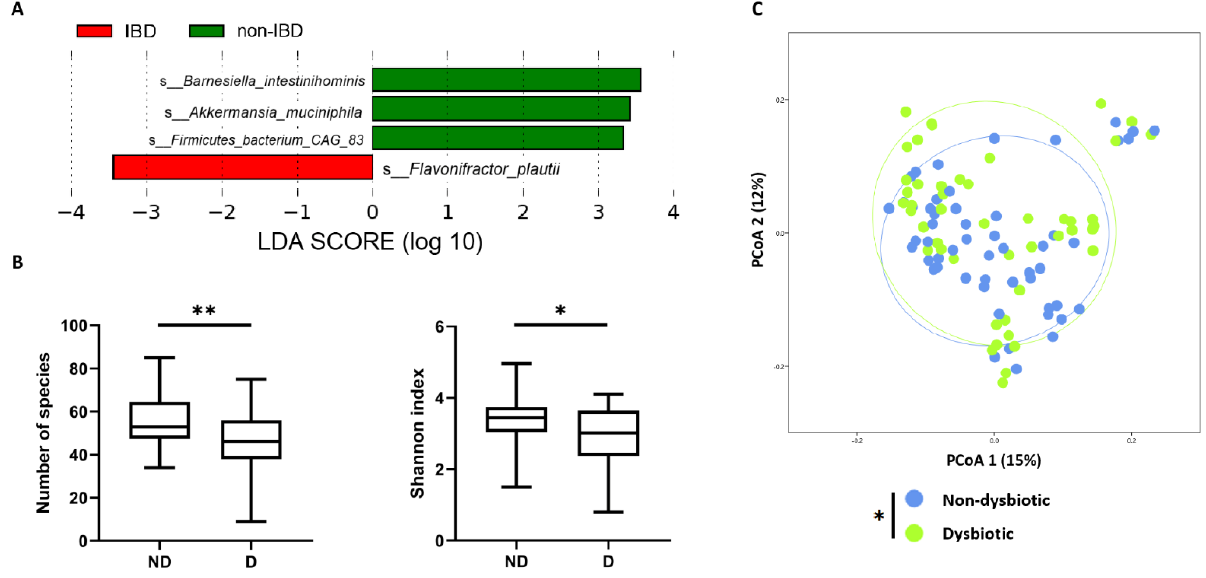
Figure 4. Discriminating bacterial species between non-IBD controls and IBD patients and diversity according to dysbiosis. ( A ) LEfSe of the four main discriminating species between IBD patients and non-IBD controls. ( B ) Alpha diversity indexes according to dysbiosis (Mann–Whitney U test). ( C ) Principal coordinate analysis of Bray–Curtis distance with each sample coloured according to the disease phenotype. PCoA1 and PCoA2 represent the top two principal coordinates that captured most of the distance. The fraction of distance captured by the coordinate is given as a percentage. Groups were compared using Permanova analysis. In all panels, * p < 0.05, ** p < 0.005. ND: non-dysbiotic, D: dysbiotic.